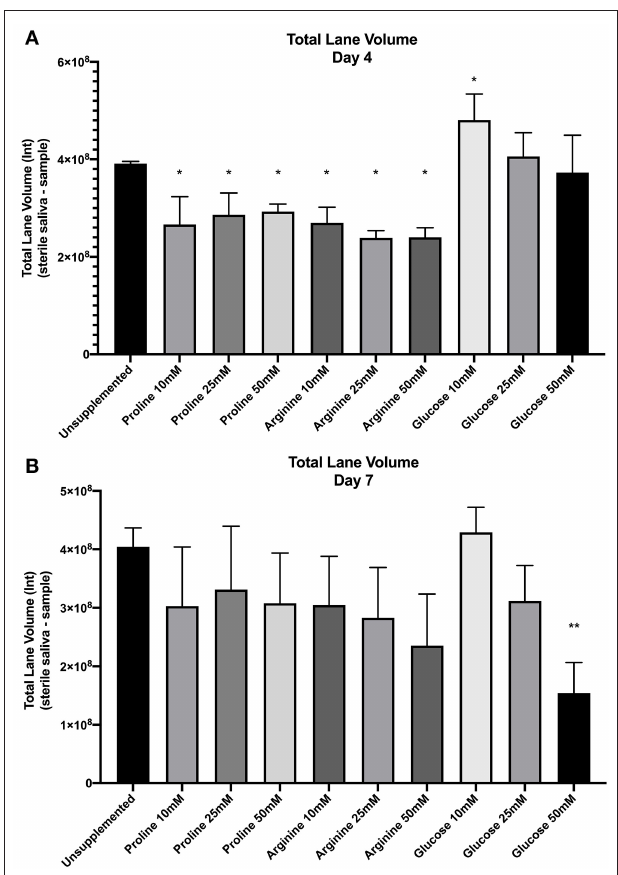
FIGURE 2 | SDS-PAGE total lane volume (arbitrary intensity units; Int) of biofilm spent saliva at day 4 (A) and day 7 (B) . Total lane volume was calculated as the total lane volume intensity of the sterile saliva growth medium minus the total lane volume intensity of the spent saliva sample ( n = 3; * p < 0.05, ** p <